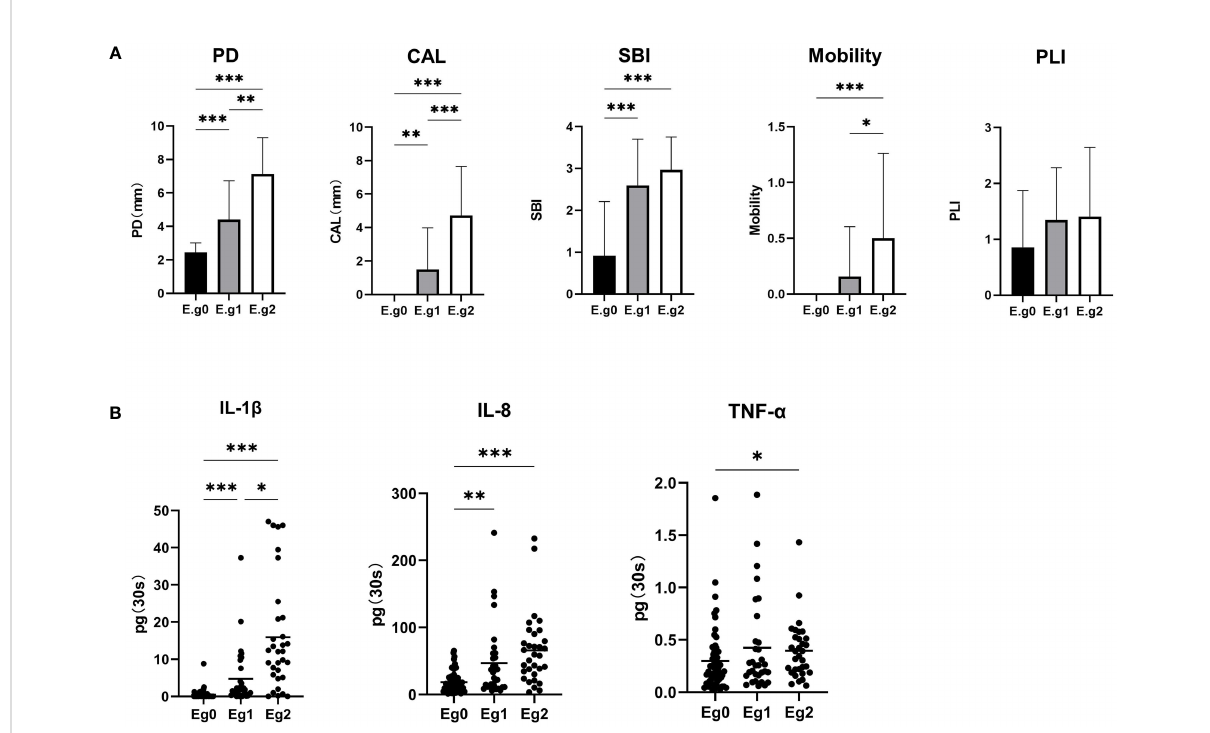
FIGURE 4 Alterations in clinical periodontal parameters and cytokines in gingival crevicular fl uid (GCF) among the Entamoeba gingivalis ( E. gingivalis ) subgroups. (A) Comparison of clinical parameters among the E. gingivalis subgroups. CAL, clinical attachment loss (mm); PD, probing depth (mm); PLI, plaque index; SBI, sulcus bleeding index. Data are represented by the mean ± standard deviation. (B) Comparison of cytokines in GCF among the E. gingivalis subgroups. Eg0, E. gingivalis negative group (n=56). Eg1, E. gingivalis low-abundance group (relative abundance <10%,